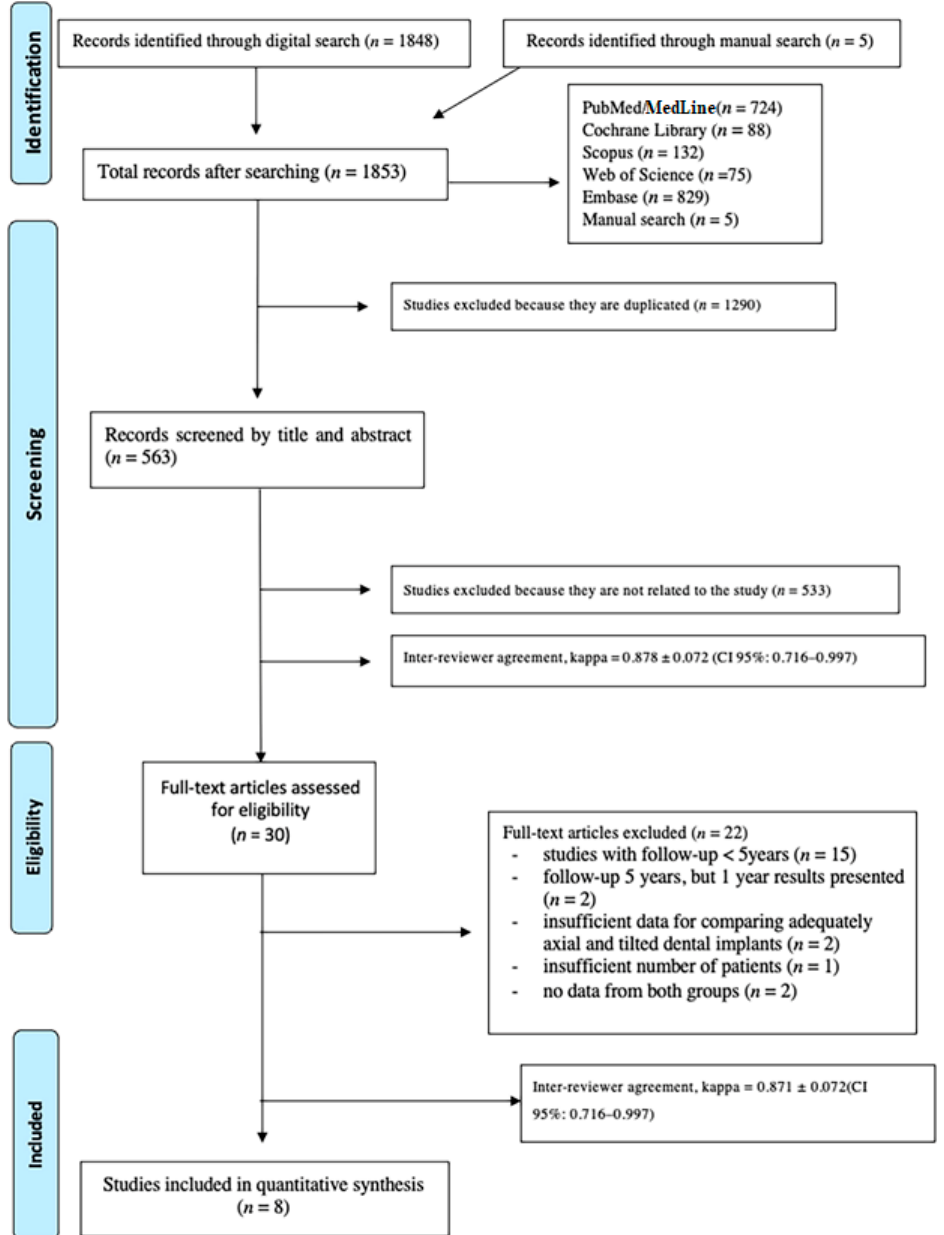
Figure 1. Flow chart of the inclusion and exclusion of studies in this review.